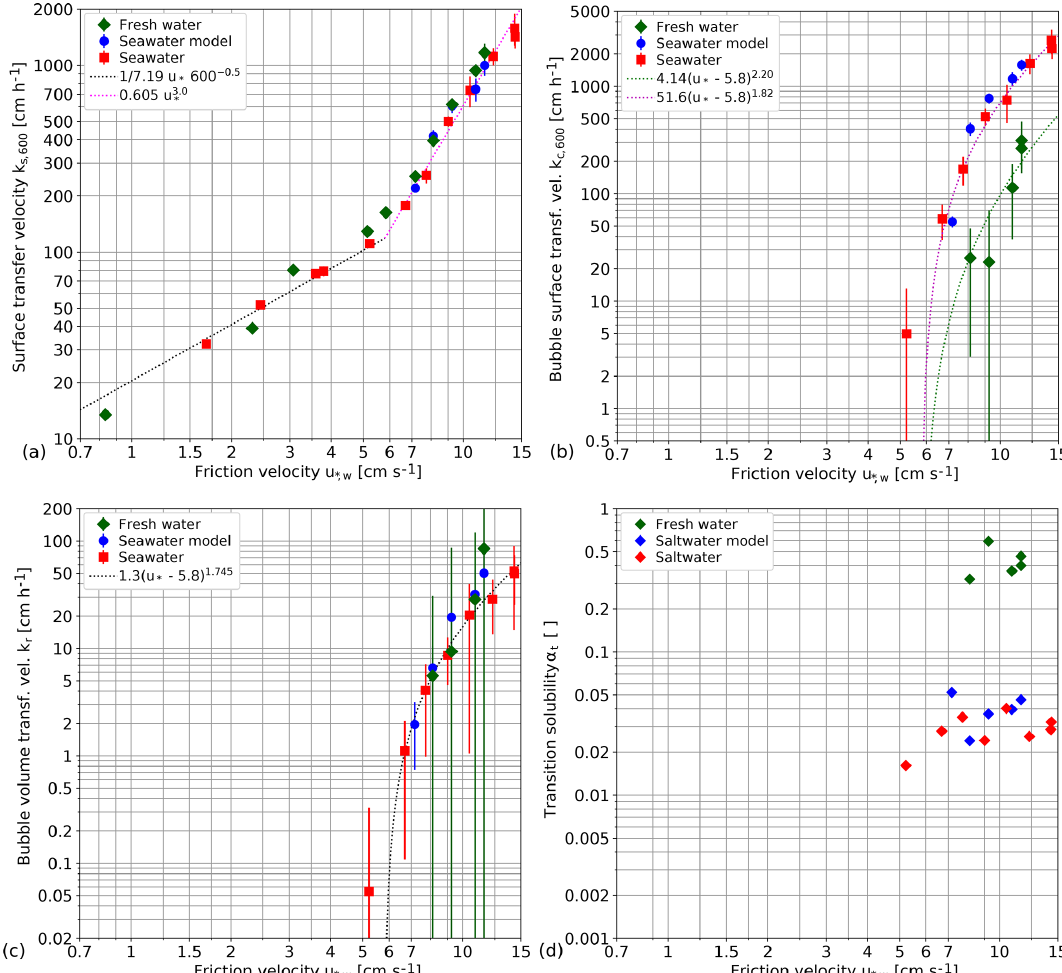
Figure 7. Fitted contribution of the different components to the gas transfer velocity: (a) surface transfer velocity k s , 600 , (b) bubble surface transfer velocity k c , 600 and (c) the bubble volume k r as a function of the water-side friction velocity in double-logarithmic presentation. Please note the different vertical scales. The graphs include error bars of the fitted parameters. In addition, the transition solubility α t computed according to Eq. (9) is shown in panel (d) without error